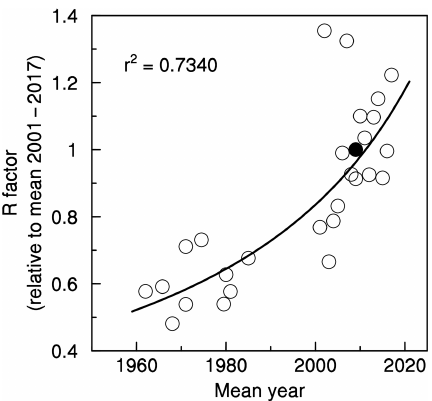
Figure 7. Average R factor relative to the 17-year mean radar- derived R factor depending on the mean year of data origin. Data below year 1990 are calculated from statewide averages determined from meteorological station records; year is the mean year of sta- tion records. Data above year 2000 are radar-derived R factors for all of Germany for individual years. The closed circle denotes the reference point (present